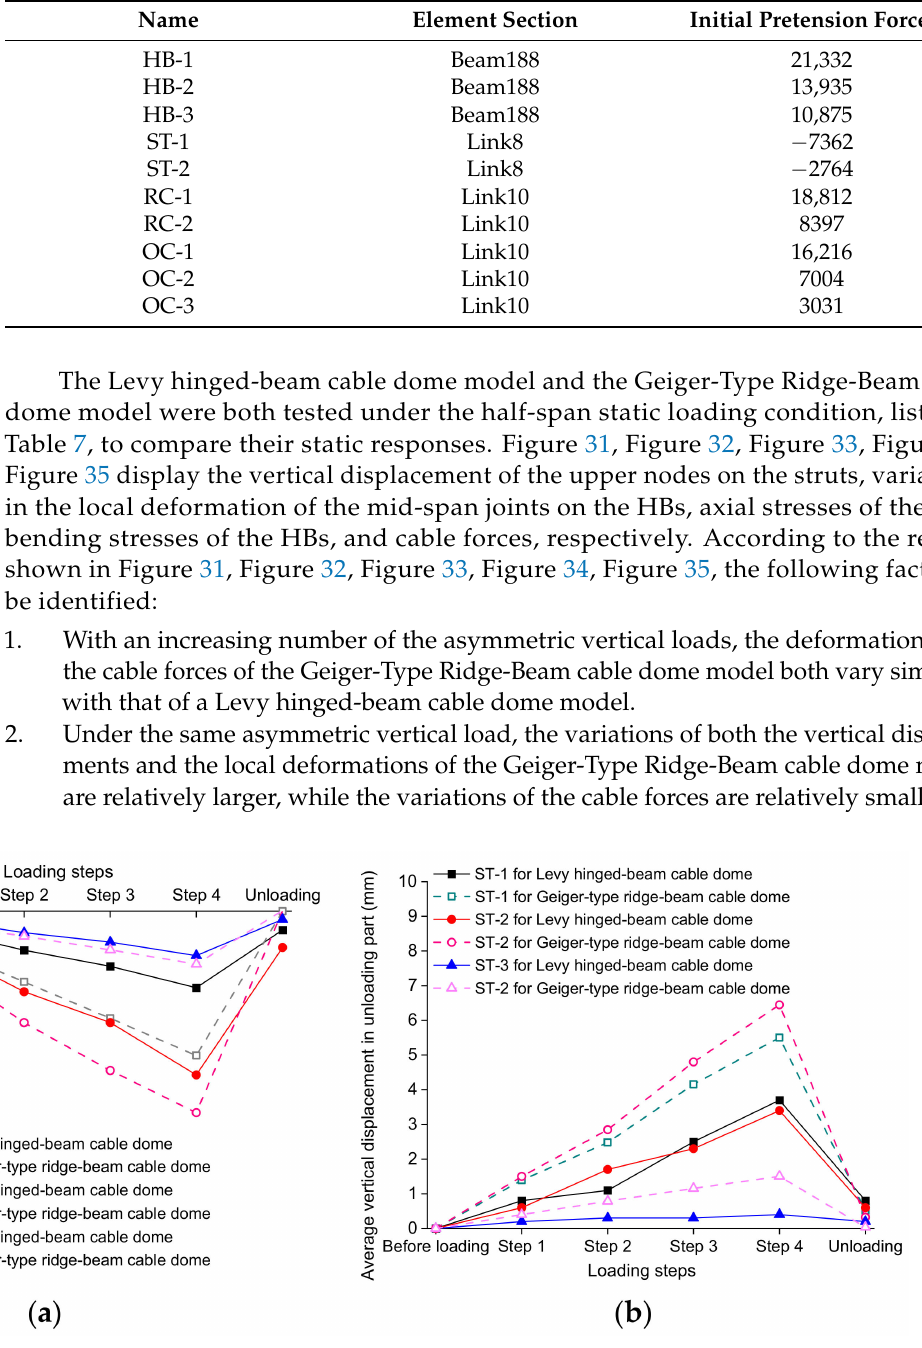
Figure 31. Comparative results of the vertical displacement on the upper nodes of the struts. ( a ) Loading part; ( b ) Unload- ing